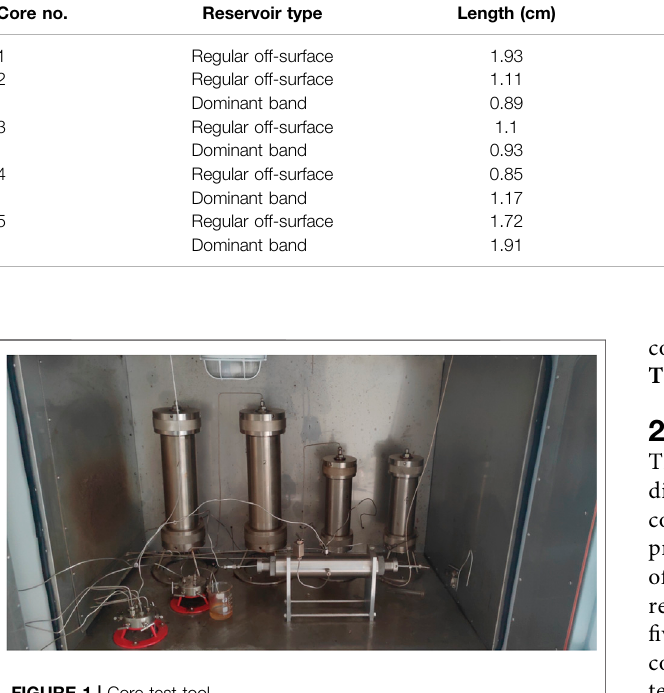
Frontiers in Physics |